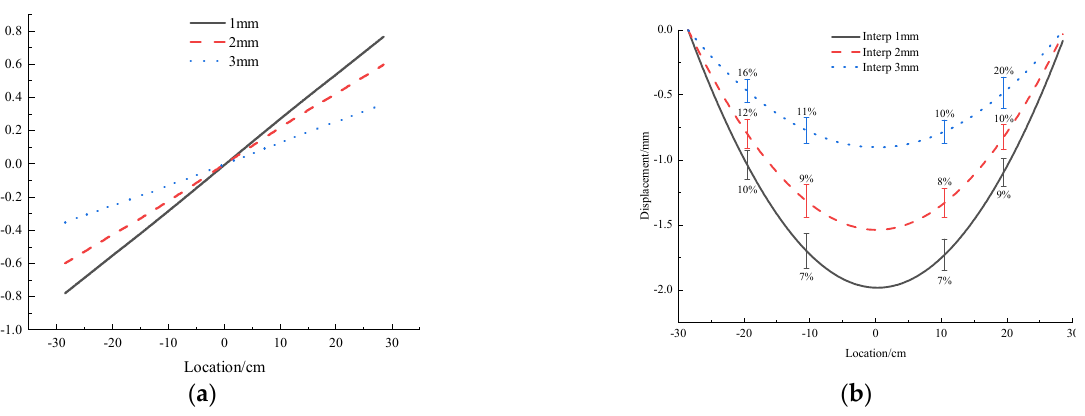
Figure 7. Angle and Displacement Curve of acrylic tunnel with 1 mm, 2 mm and 3 mm thickness under concentrated load. ( a ) Angle. ( b ) Displacement.